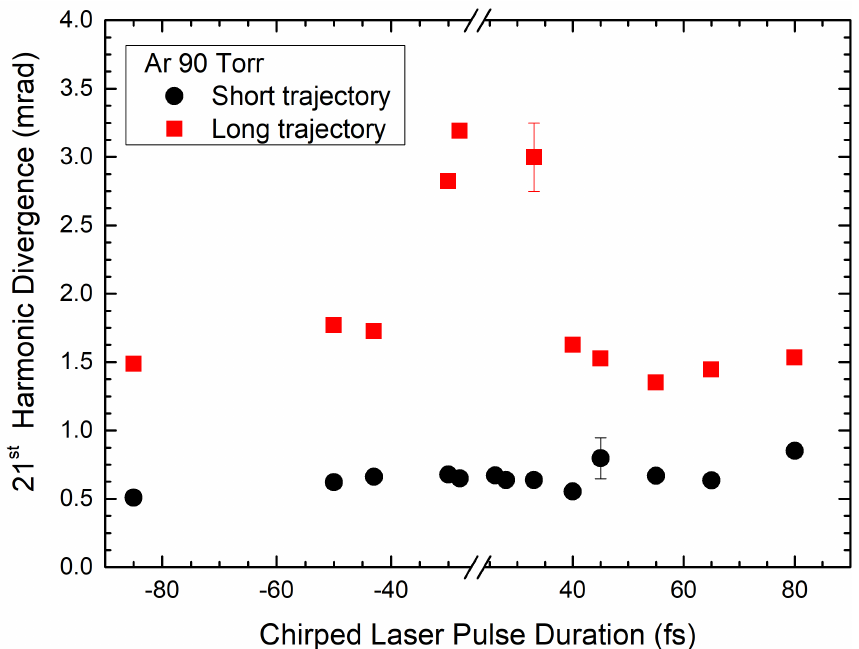
Figure 5. Experimentally determined divergence of the 21st harmonic short (black solid circle) and long (red solid square) trajectories as a function of the chirped laser pulse duration for the case of 90 Torr Ar gas pressure of Figure 2. Indicative error bars for the short and long trajectories are